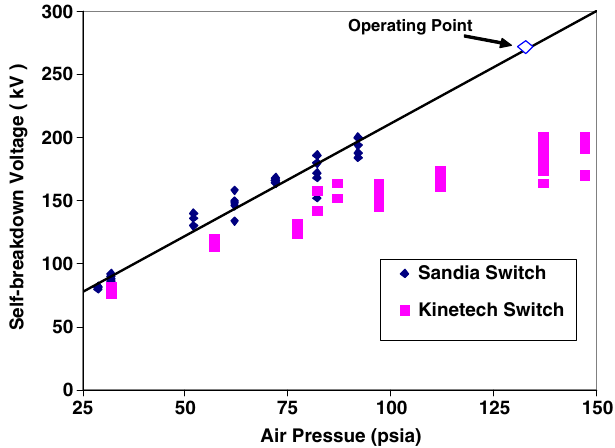
FIG. 12. (Color) Self-breakdown voltages of the Sandia and Kinetech switches as a function of dry air pressure. We extrapo- lated a fit through each switch’s self-break curve to allow us to determine a 200 kVoperating point that would have the switch at (cid:1) 70% of its self-breakdown voltage. The extrapolated fit and 200 kV, 72% SBV operating point are shown for the Sandia switch.